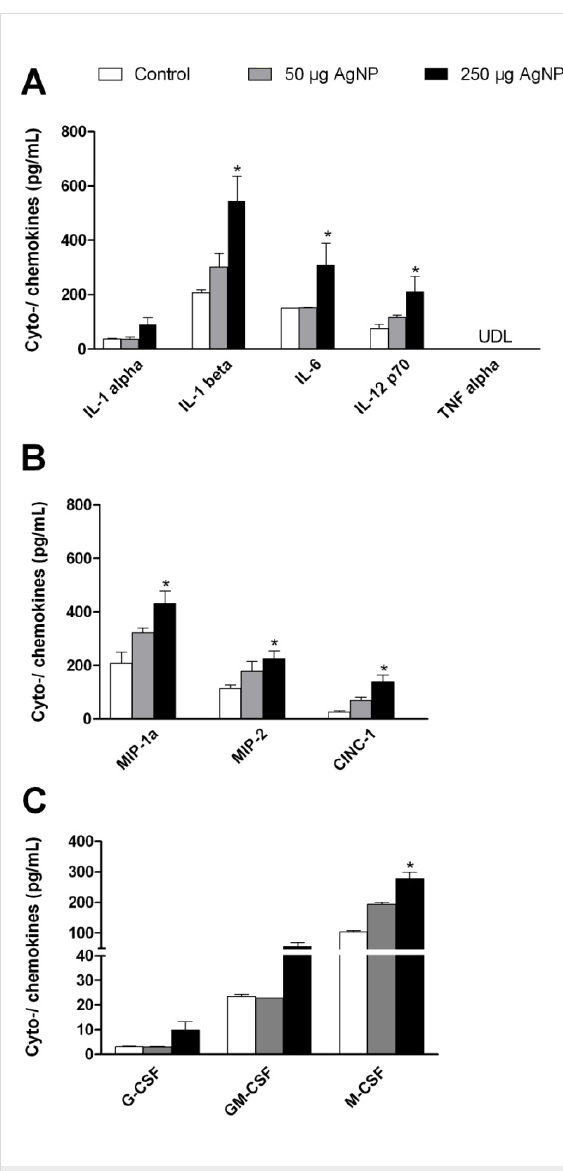
Figure 6: Cytokine levels in BALF 24 hours after the intratracheal instillation of PVP-AgNP (A: proinflammatory cytokines; B: chemokines; C: colony-stimulating factors). For the lower limits of detection see “Experimental”. Values are mean ± SEM; n = 5 for each treatment group; *p < 0.05 vs control. UDL = under detection limit.